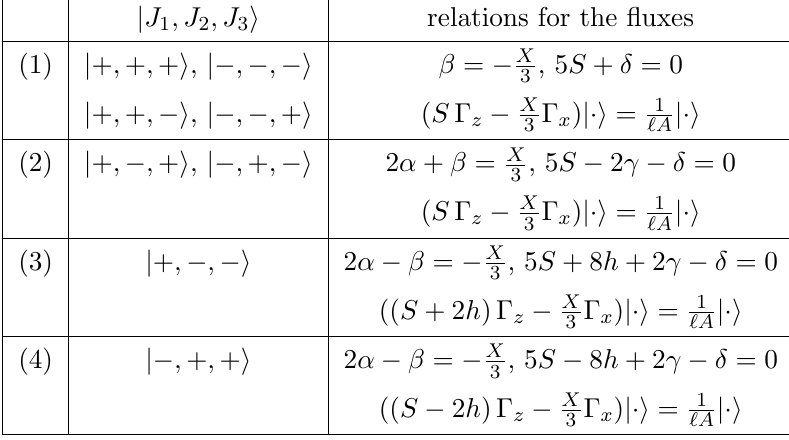
Table 2 . Decomposition of (3.46) KSE into